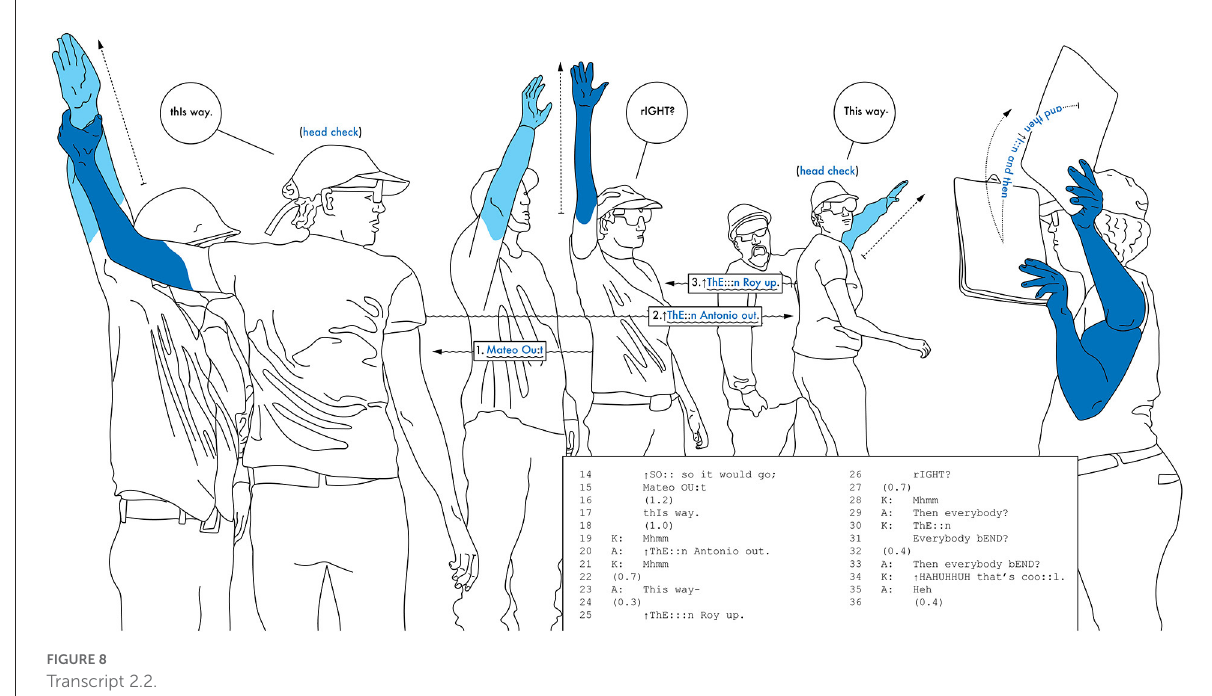
FIGURE8 Transcript